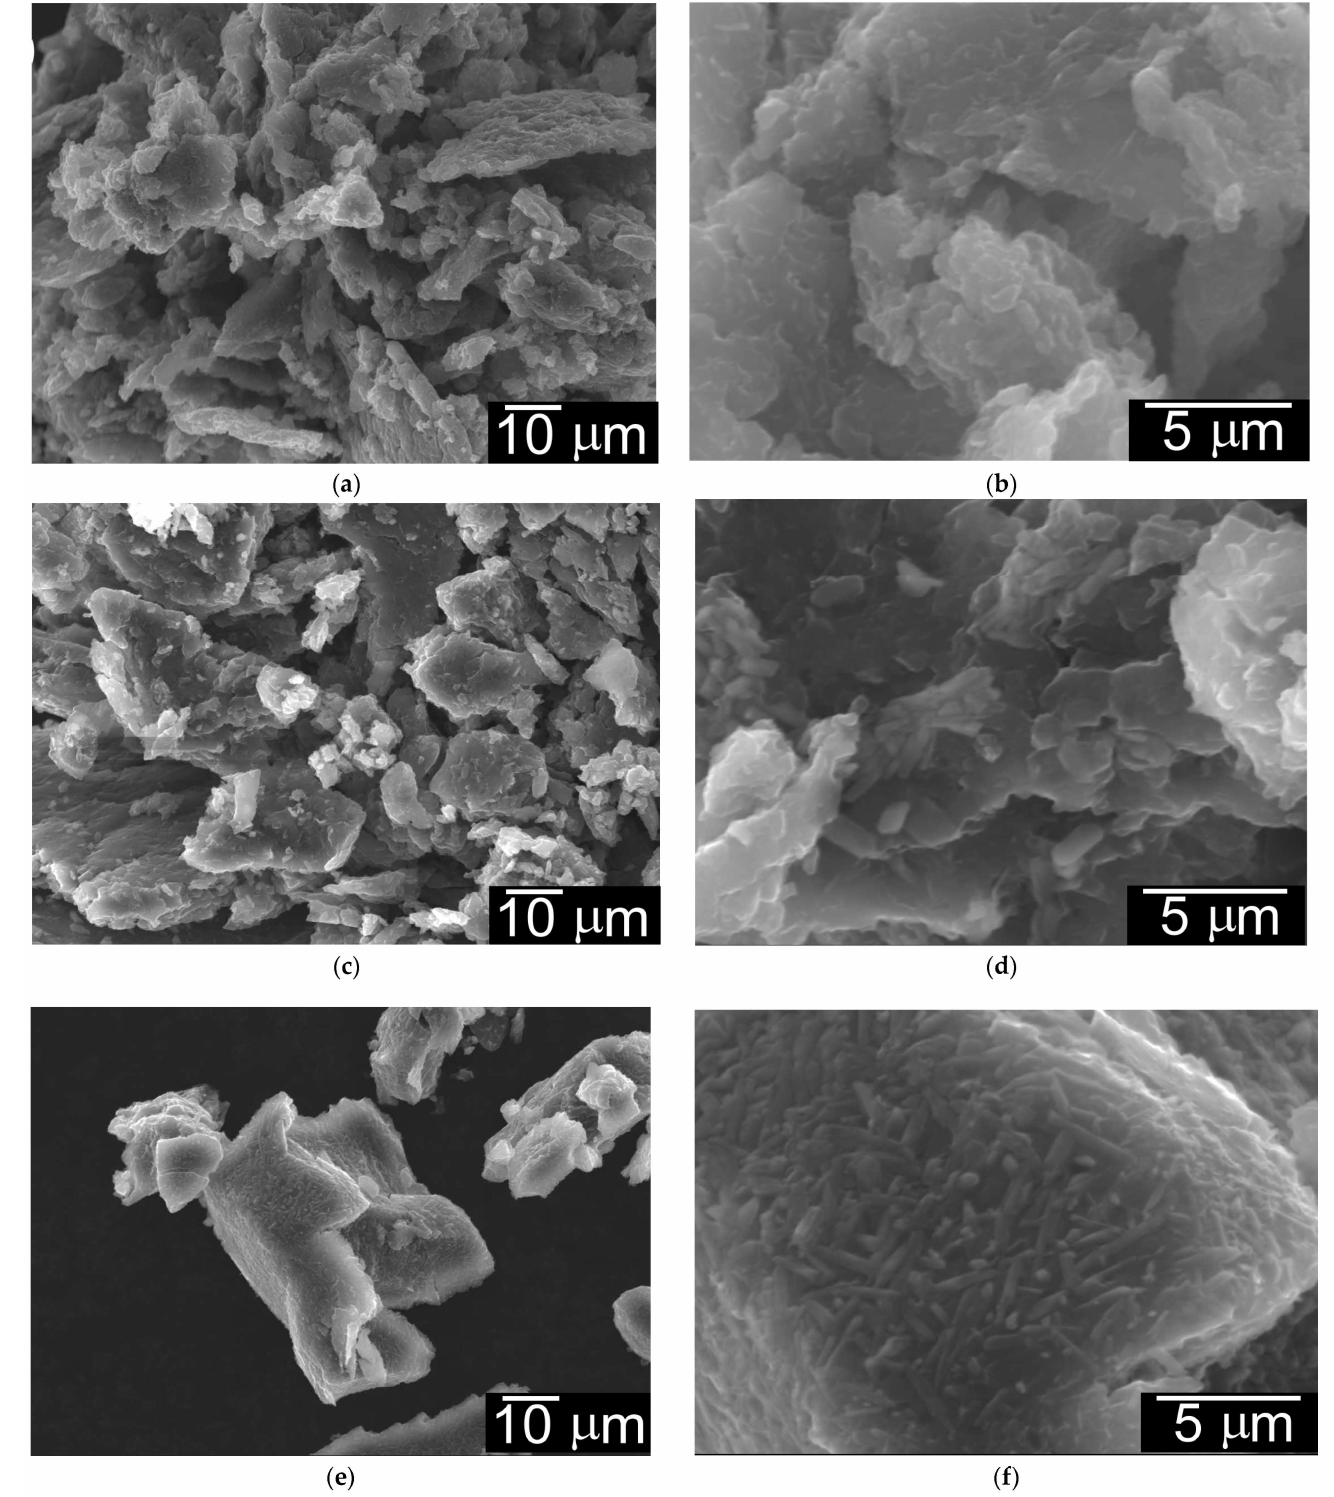
Figure 20. SEM images of polymer composites. ( a , b ) N3, ( c , d ) N4, and ( e , f ) N5. Increasing the fucoidan element in the composite increased the size of the fine bulk. A domain-like structure was observed on the surface of